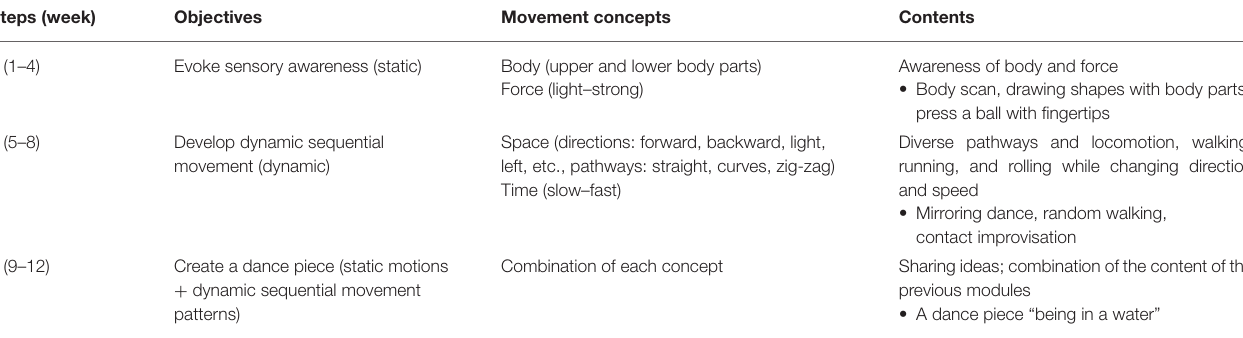
TABLE 2 | Progression of the dance modules. Steps